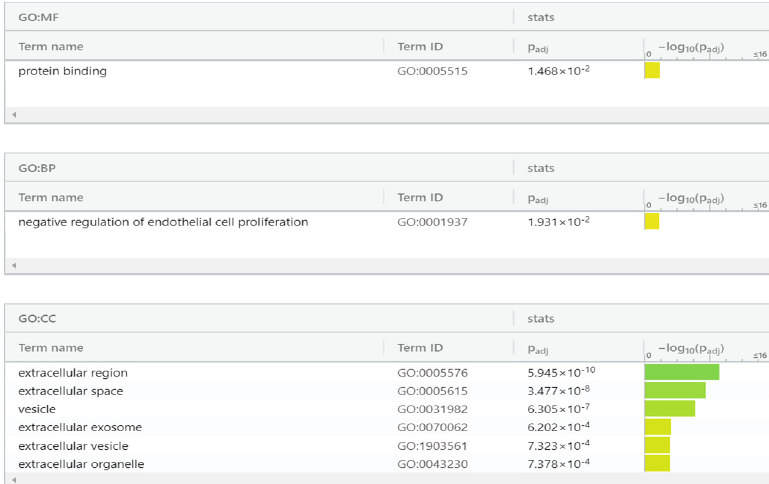
Figure 8. gProfiler classification of Oncology III panel proteins in the EC serum according to their molecular function, biological processes, cellular component.